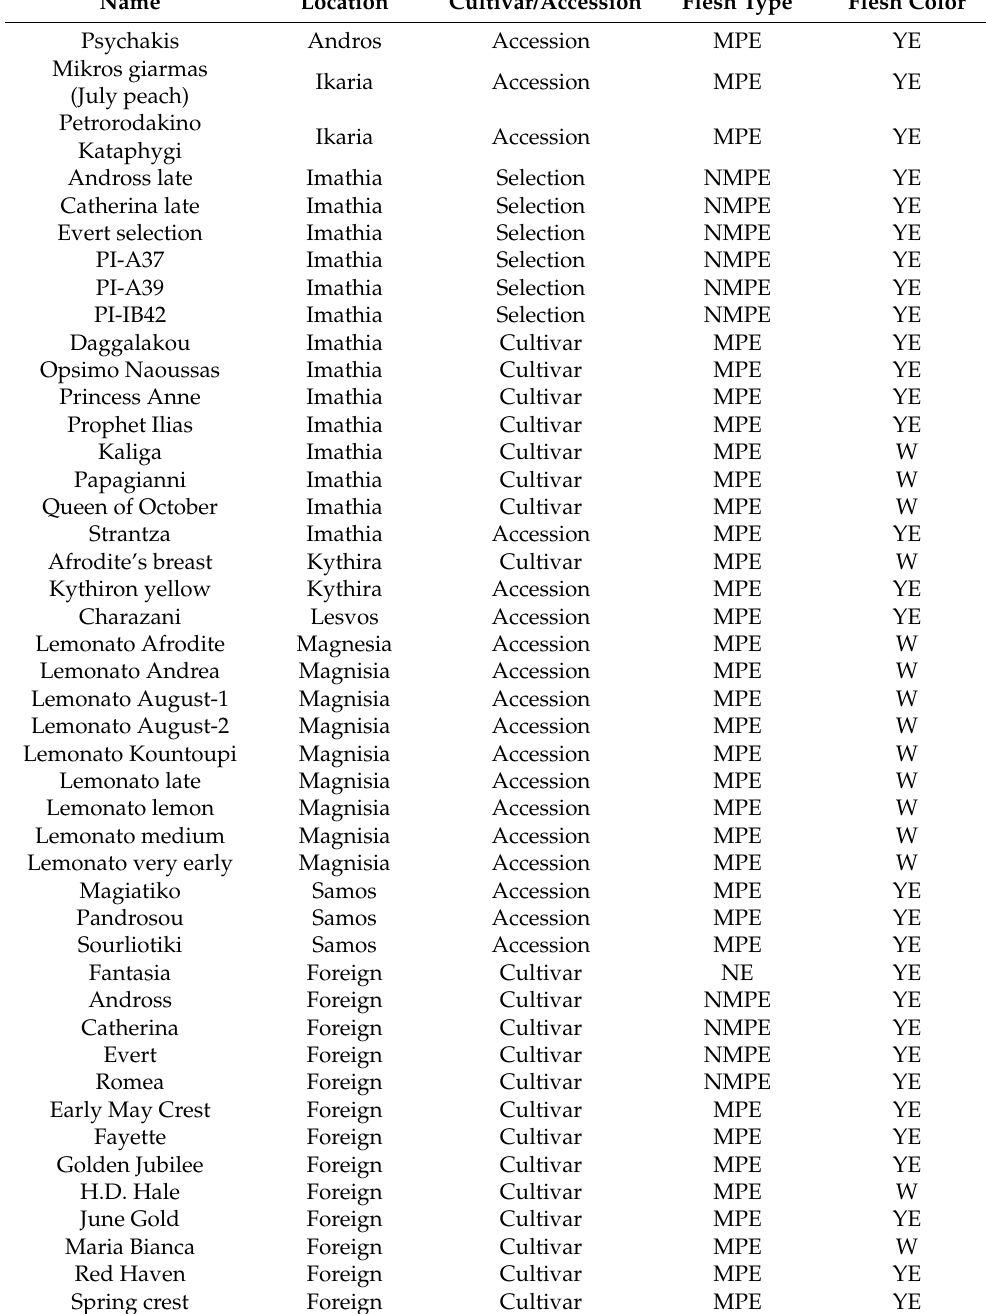
Table 1. Name, location, flesh type and flesh color in 32 local peach cultivars/accessions prospected from various areas in Greece, and 13 old foreign peach cultivars grown in an ex situ collection. MPE, melting peach; NMPE, non − melting peach; NE, nectarine; YE, yellow; W,